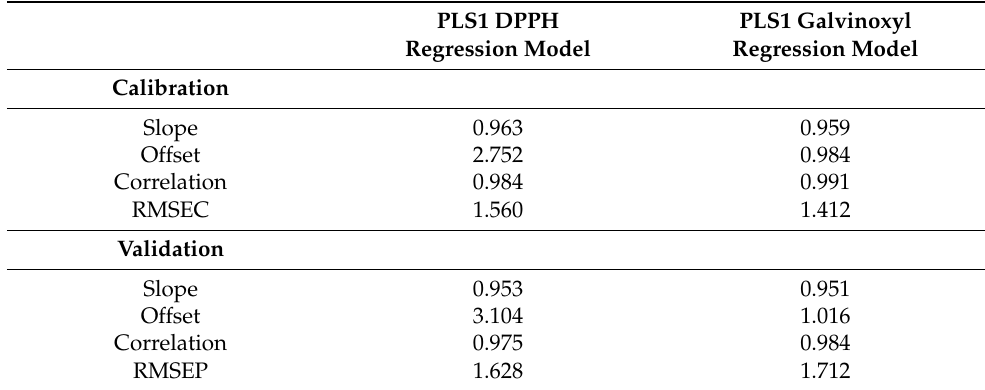
Table 4. Results of PLS1-DPPH and PLS1-galvinoxyl regression models in calibration and validation.